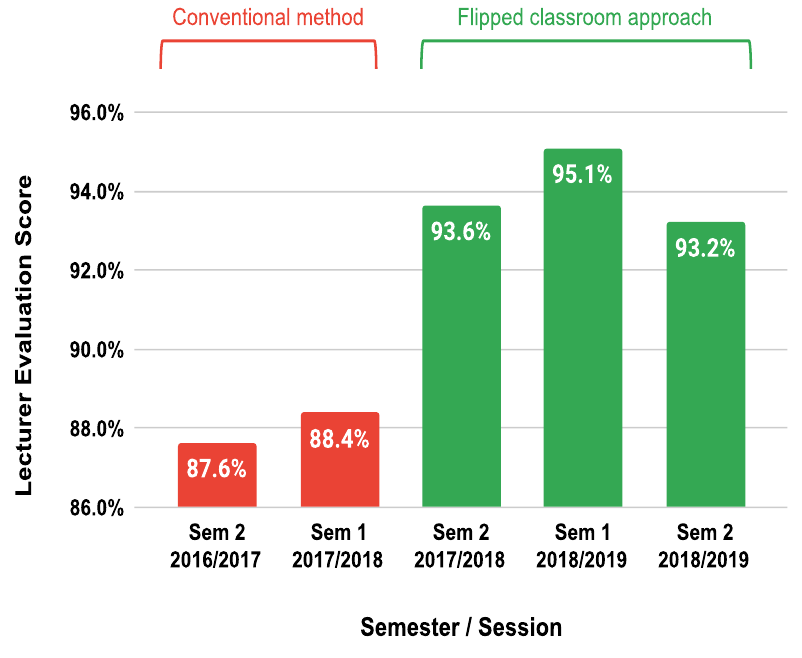
Fig. 3. Lecturer evaluation score of every observed semester as rated by the